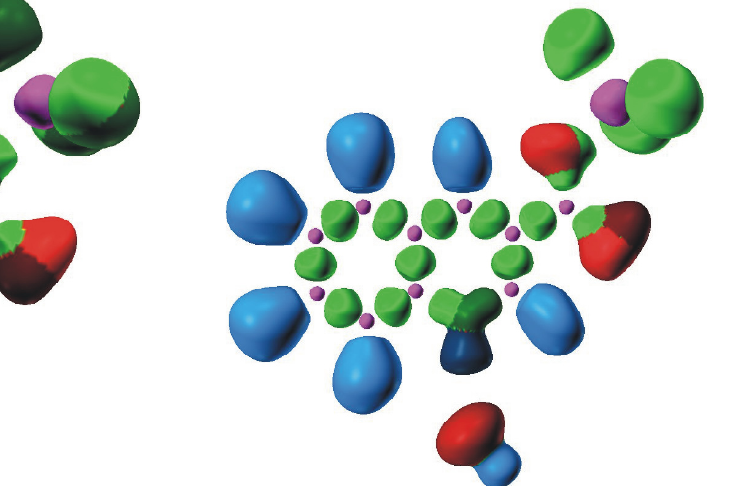
Figure 4. The ELF isosurfaces drawn at 0.70 for the structures without (3, left) and with (4, right) hydrogen